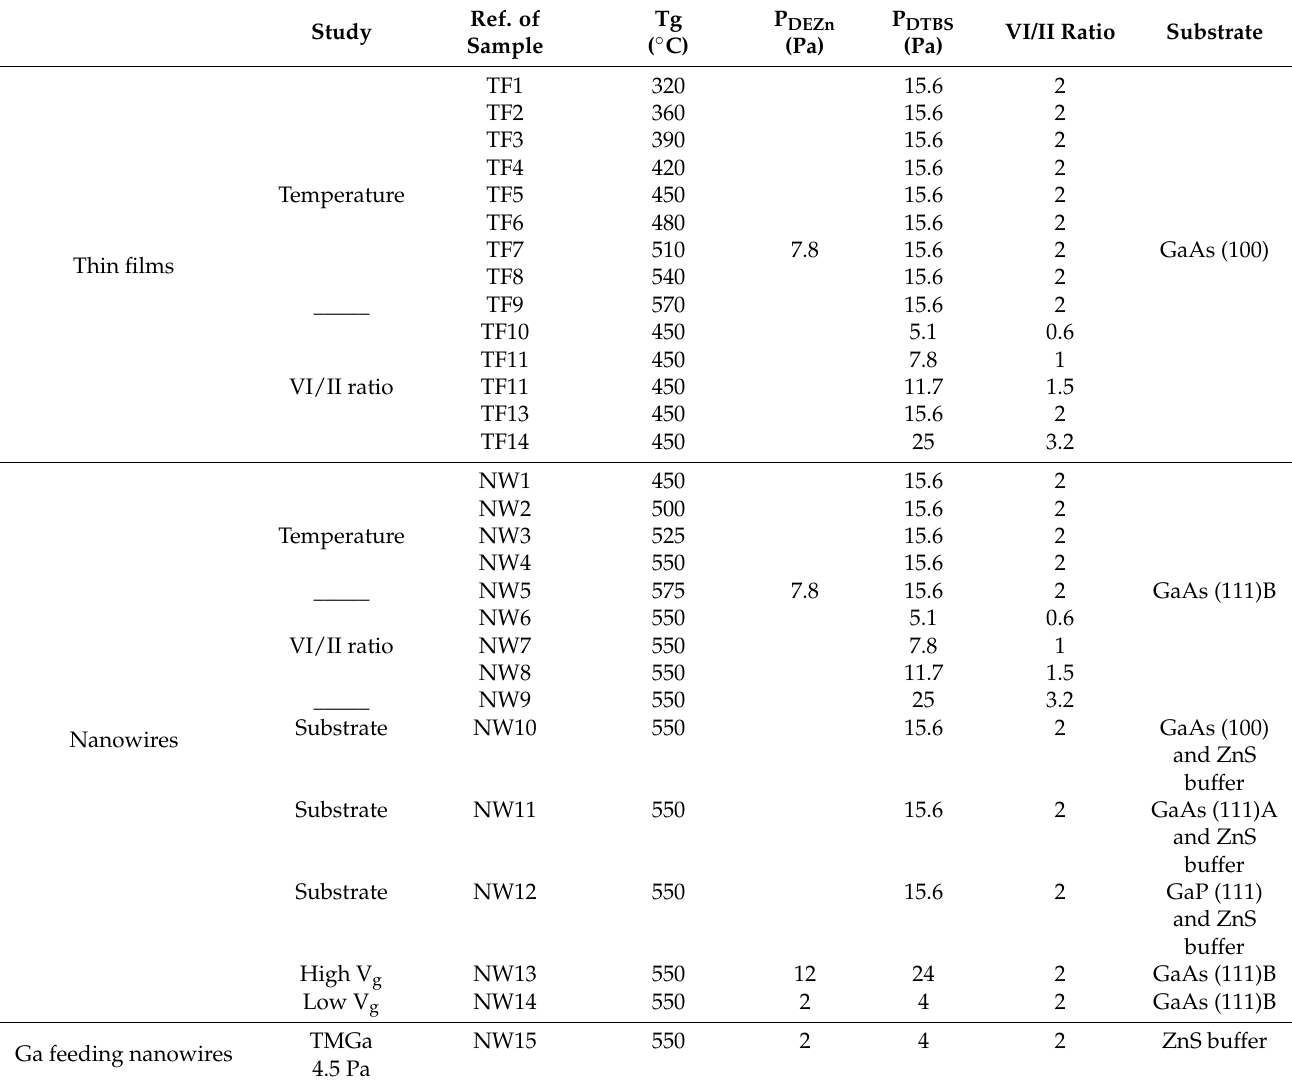
Table 1. Sample list, indicating growth